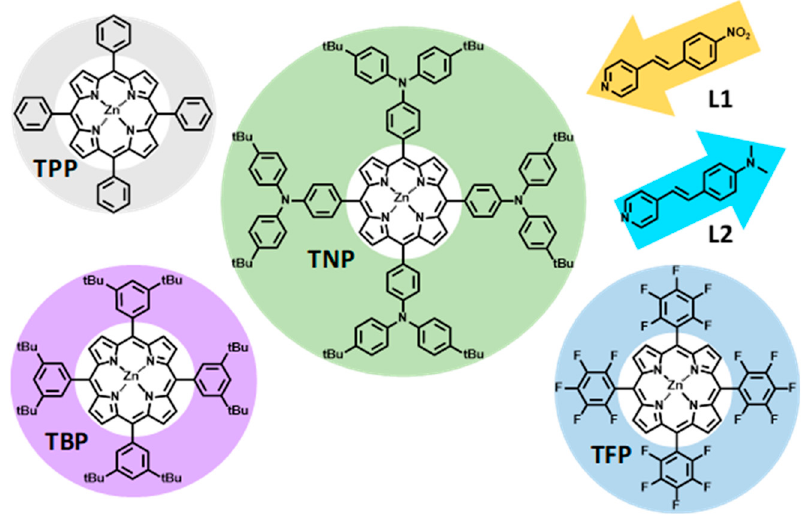
Figure 1. Molecular structures of Zn II porphyrins and ligands.